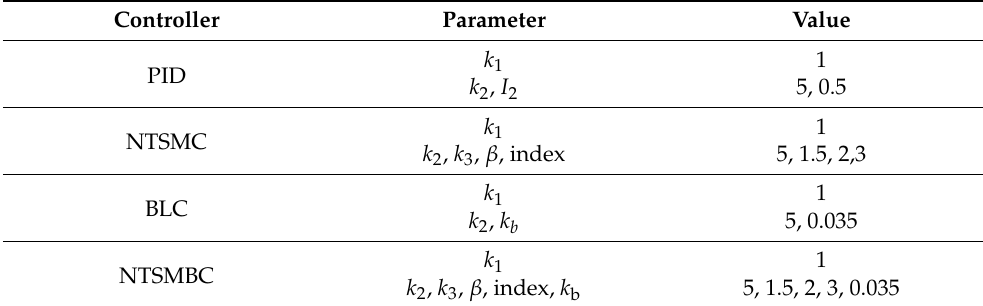
The parameters of the roll angle controllers are shown in Table 1. Table 1. Parameters of the CDR roll angle controllers.